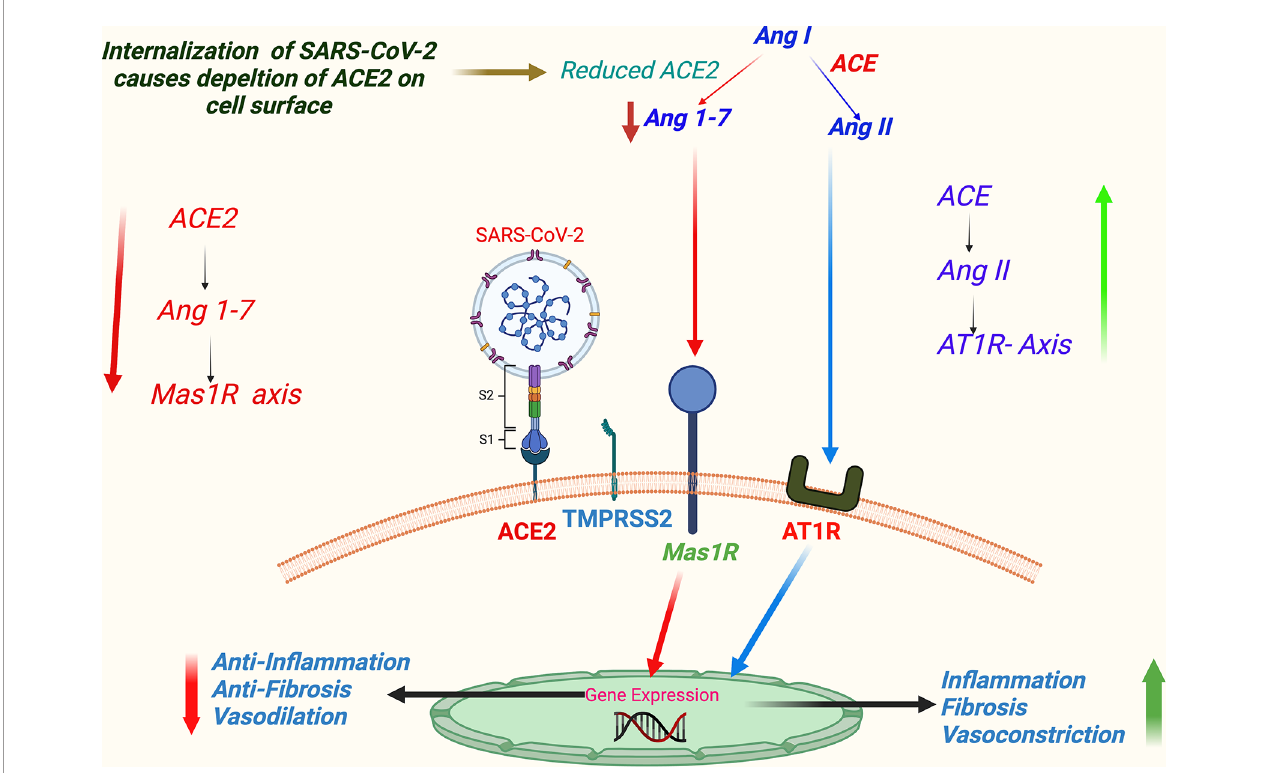
FIGURE 4 | A schema of virus binding-induced ACE2-mediated dysregulation of RAAS in COVID-19. (SARS-CoV-2 host cell entry receptor ACE2 is an analog of ACE that performs a key step in regulation of RAAS — the conversion of Ang I to Ang II in lung epithelium. Ang II primarily acts through AT1 receptor. Alternatively, Ang II is metabolized to angiotensin 1-7 (Ang 1-7), which further acts through Mas 1R. Physiologically ACE/Ang II/AT1R axis keeps in balance with ACE2/Ang 1-7/ Mas 1R axis. Supposedly, binding of SARS-CoV-2 downregulates ACE2 signaling, and consequently ACE/Ang II/AT1R axis gets an upper hand favoring vascular constrictions, tissue in fl ammation, and fi brosis.) Abbreviations: ACE, angiotensin converting enzyme; Ang I, angiotensin-1; Ang II, angiotensin-2; AT1R, angiotensin 1 receptor; COVID-19, coronavirus disease 2019; Mas 1R, Mas 1 receptor; RAAS, renin – angiotensin – aldosterone system; SARS-CoV-2, severe acute respiratory syndrome coronavirus